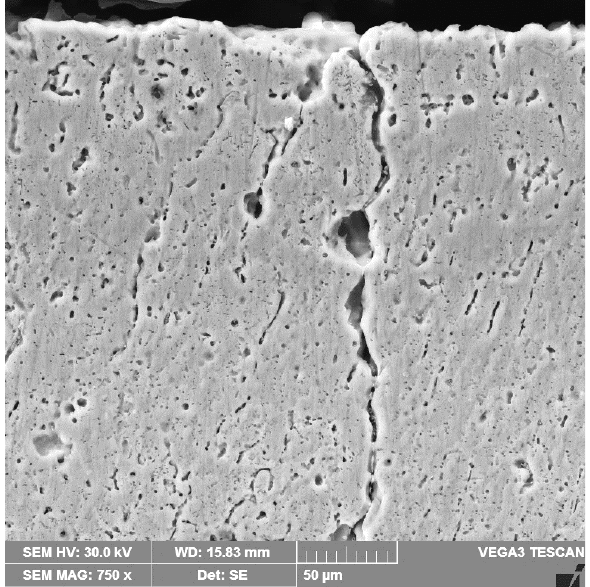
Figure 11. SEM image of a cross section with microcracks through the remelted layer, with Is = 250 A.